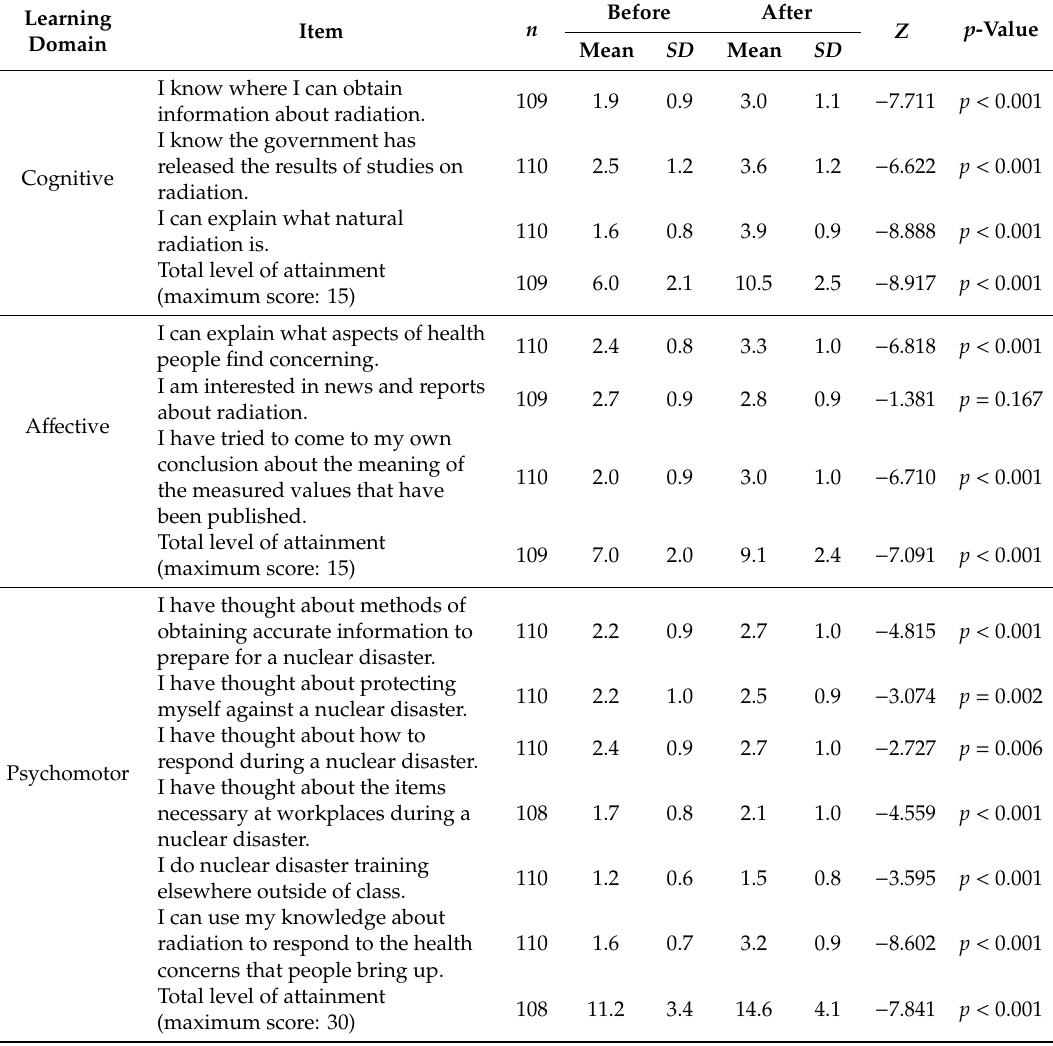
Table 1. Level of attainment on three domain goals before and after the